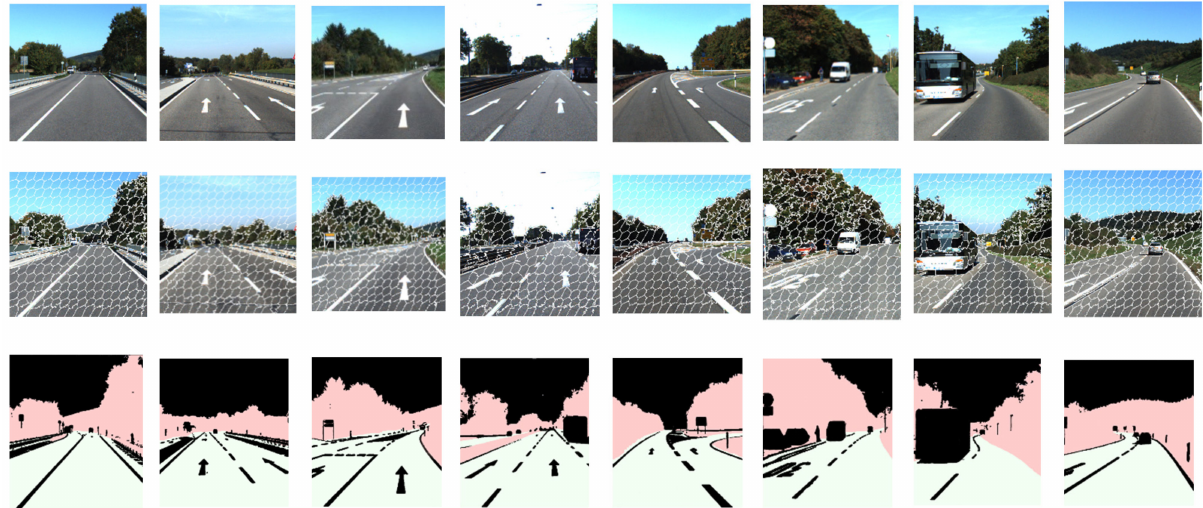
Figure 3. Segmentation results of Karlsruhe Institute of Technology and Toyota Institute of Technology (KITTI) dataset. From top to bottom are original image, superpixels, and output image of our